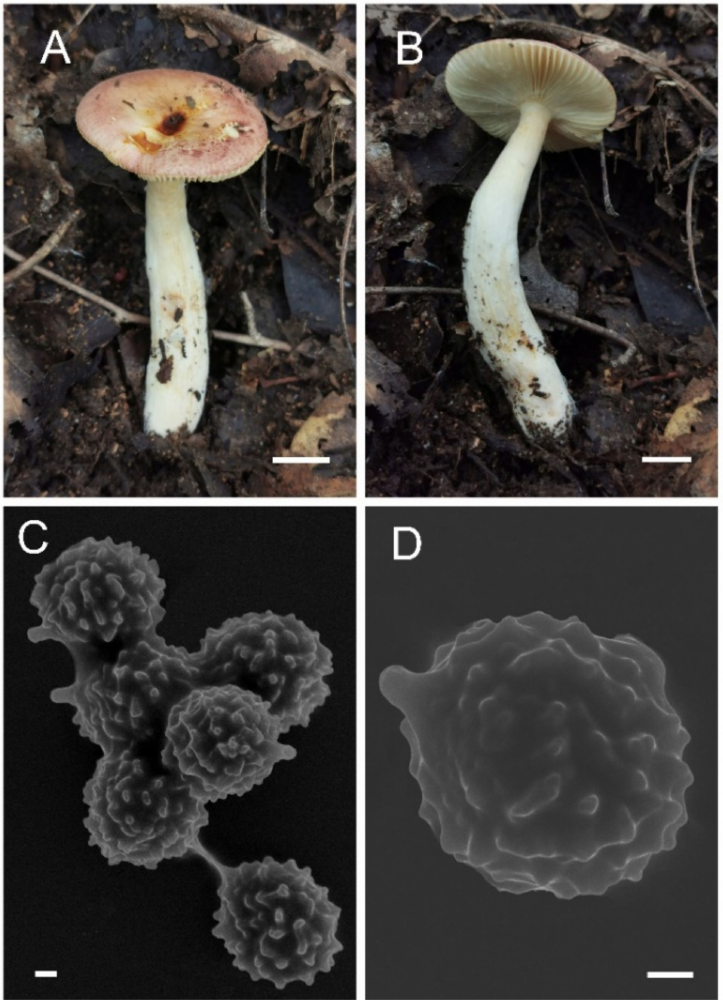
Figure 23. Russula yanshanensis (BJTC C561). ( A , B ) Basidiomata. ( C , D ) Basidiospores. Scale bar: ( A , B ) = 10 mm, ( C , D ) = 1 µ